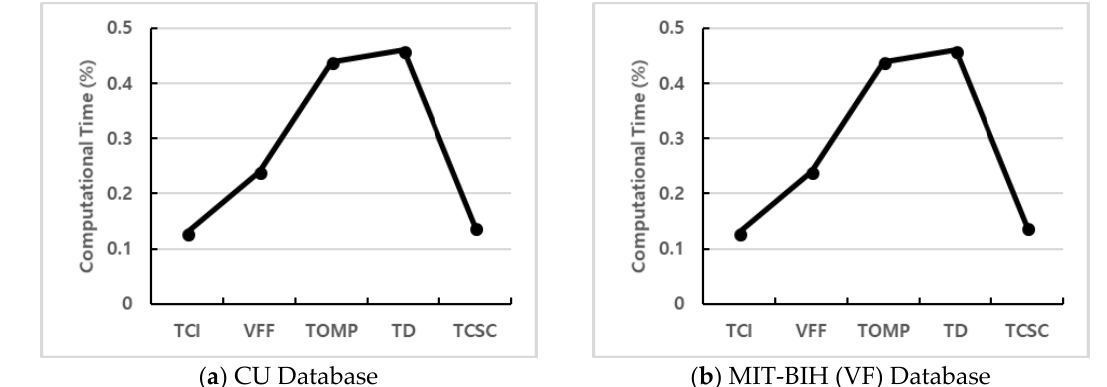
Figure 12. Relative calculation time.